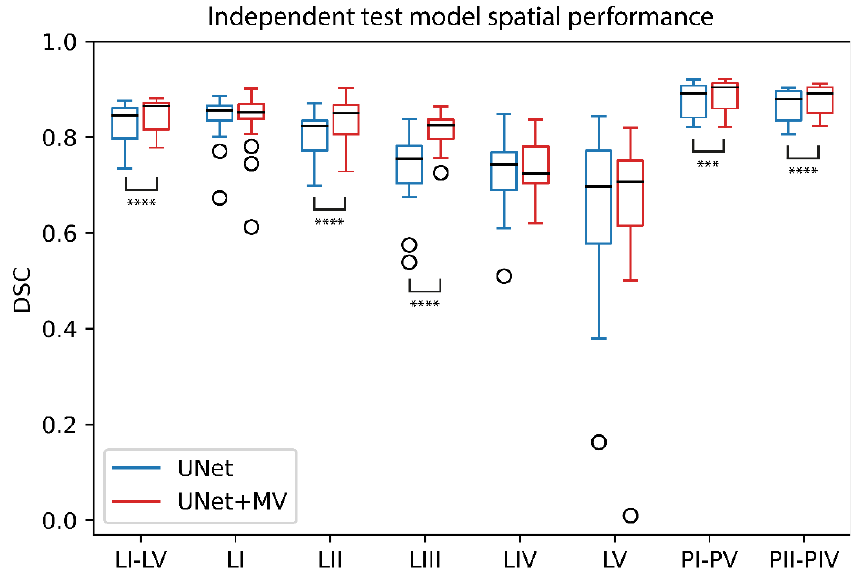
Figure 7. UNet and UNet+MV spatial model performances in the independent test. Structures for which differences between model configurations were statistically significant are denoted by significance bars. ***: p < 0.001; ****: p < 0.0001; Abbreviations: DSC: Dice similarity coefficient; MV: multi-view.